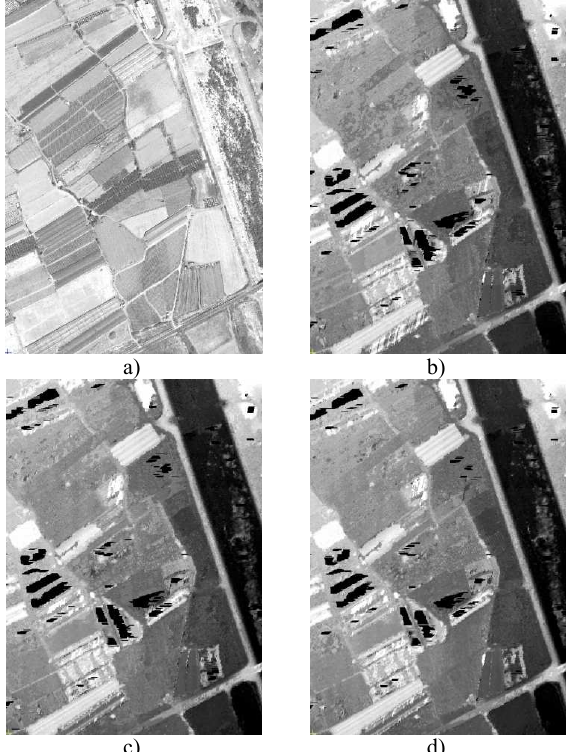
Figure 3. DSMs from GeoEye-1 stereopair using orthometric heights in a zone near of the Almanzora river. a) Orthoimage from GeoEye-1, b) DSM with CCRS and 45 GCPs, c) DSM with RPC0 and 7 GCPs, d) DSM with RPC0 and 12